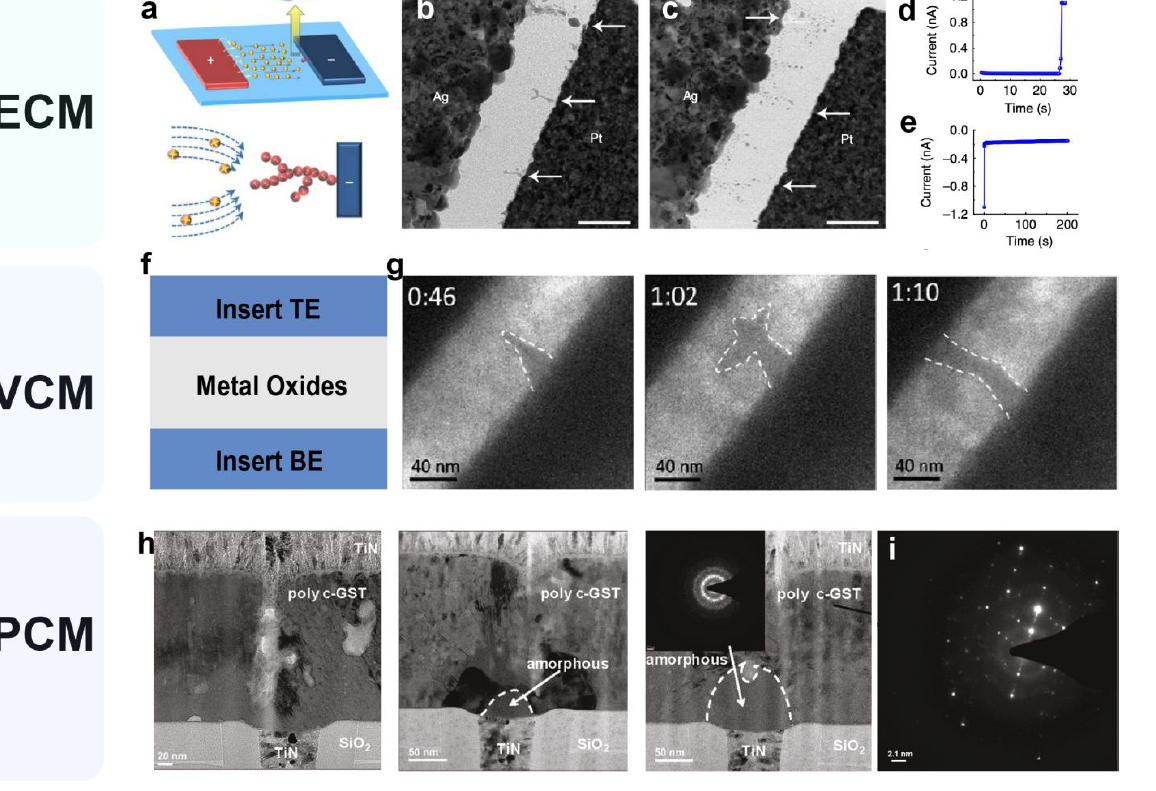
Figure 3. Memristor resistance switching mechanism with three different types. ( a ) Schematic of dendritic CF formation in the Ag/SiO 2 /Pt structure. ( b , c ) TEM image of Ag/SiO 2 /Pt device after set ( b ) and reset ( c ) process. Arrows illustrate CF formation. ( d , e ) Correspondence of I-t curve to CF annihilation process. Reproduced with permission [47] Copyright 2012, Springer Nature. ( f ) VCM device structure diagram. ( g ) In situ TEM image of filament growth in ZnO thin film VCM device. Reproduced with permission [49] Copyright 2013, American Chemical Society. ( h ) Cross-sectional TEM image of a GST-based electronic synapse. ( i ) The electron diffraction pattern in the fully reset state. Reproduced with permission [51] Copyright 2013, American Chemical